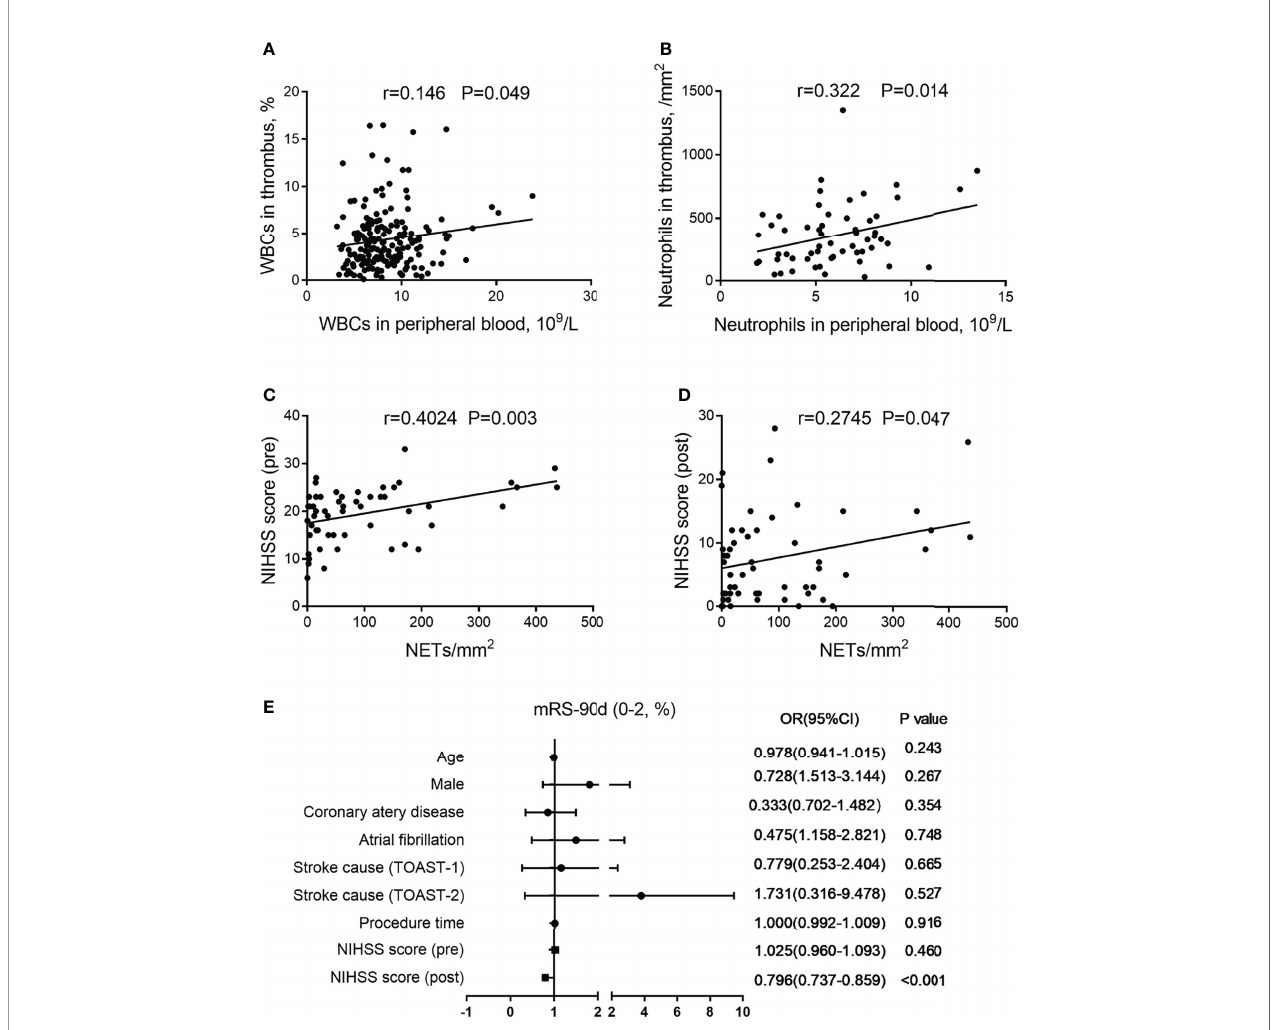
FIGURE 3 | Association of (neutrophil extracellular traps) NETs in thrombi with clinical features. (A) Correlation between white blood cells (WBCs) in thrombi and WBCs in peripheral blood. (B) Correlation between neutrophils in thrombi and neutrophils in peripheral blood. (C) Correlation between NIHSS score (pre) and NETs in thrombi. (D) Correlation between NIHSS score (post) and NETs in thrombi. (E) Forest plot of multivariate logistic regression analysis for patients with AIS, including possible outcome-in fl uencing factors regarding the correlation analysis. AIS, acute ischemic stroke; NIHSS, National Institutes of Health Stroke Scale; mRS, modi fi ed Rankin